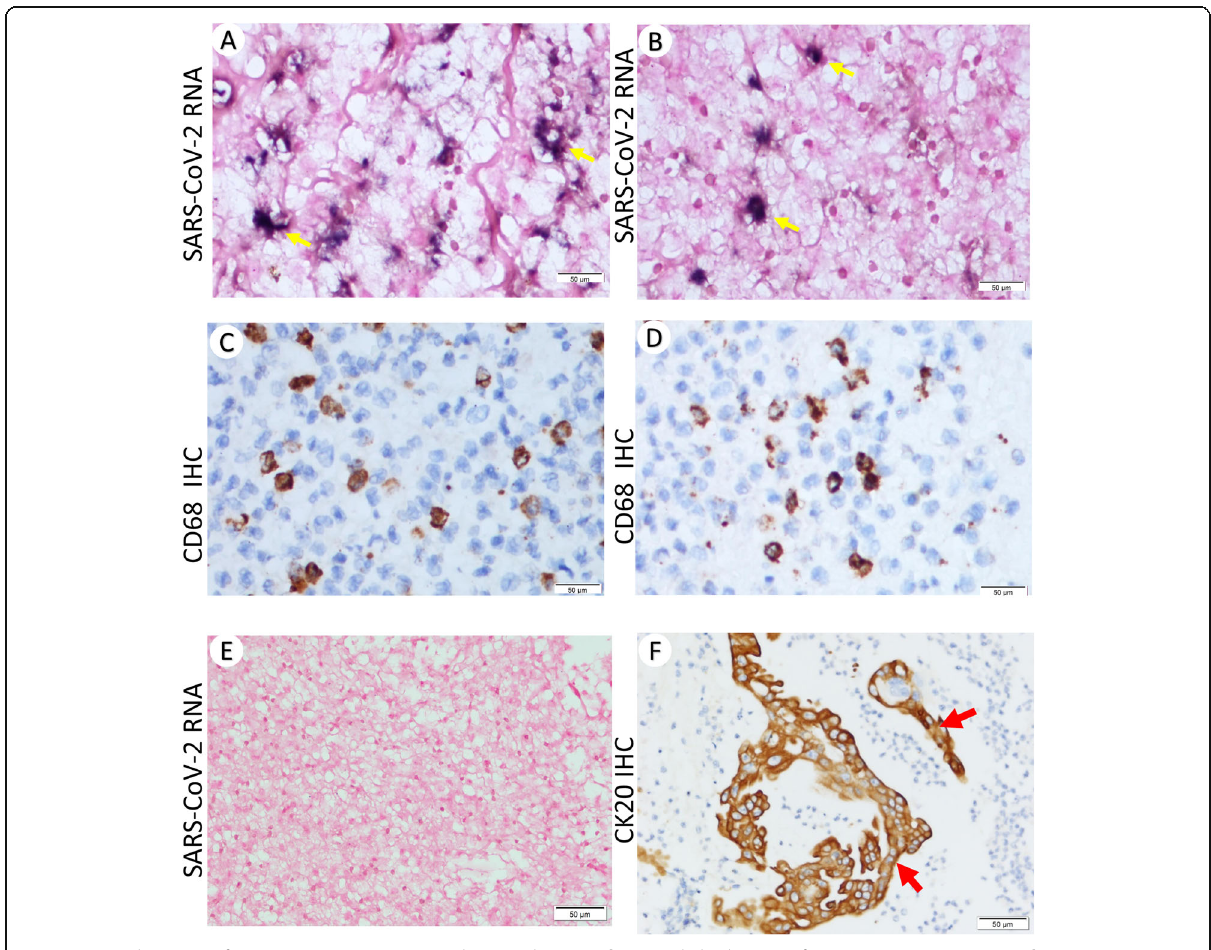
Fig. 3 In situ detection of SARS-CoV-2 RNA in intestinal macrophages. a , b In situ hybridization of SARS-CoV-2 RNA (400X) c , d Immunohistochemistry of CD68 (400X). e in situ hybridization of SARS-CoV-2 RNA in enteric tissue of uninfected individual, f Immunohistochemistry of CK20 (400X). a and c , b and d are from same regions of adjacent